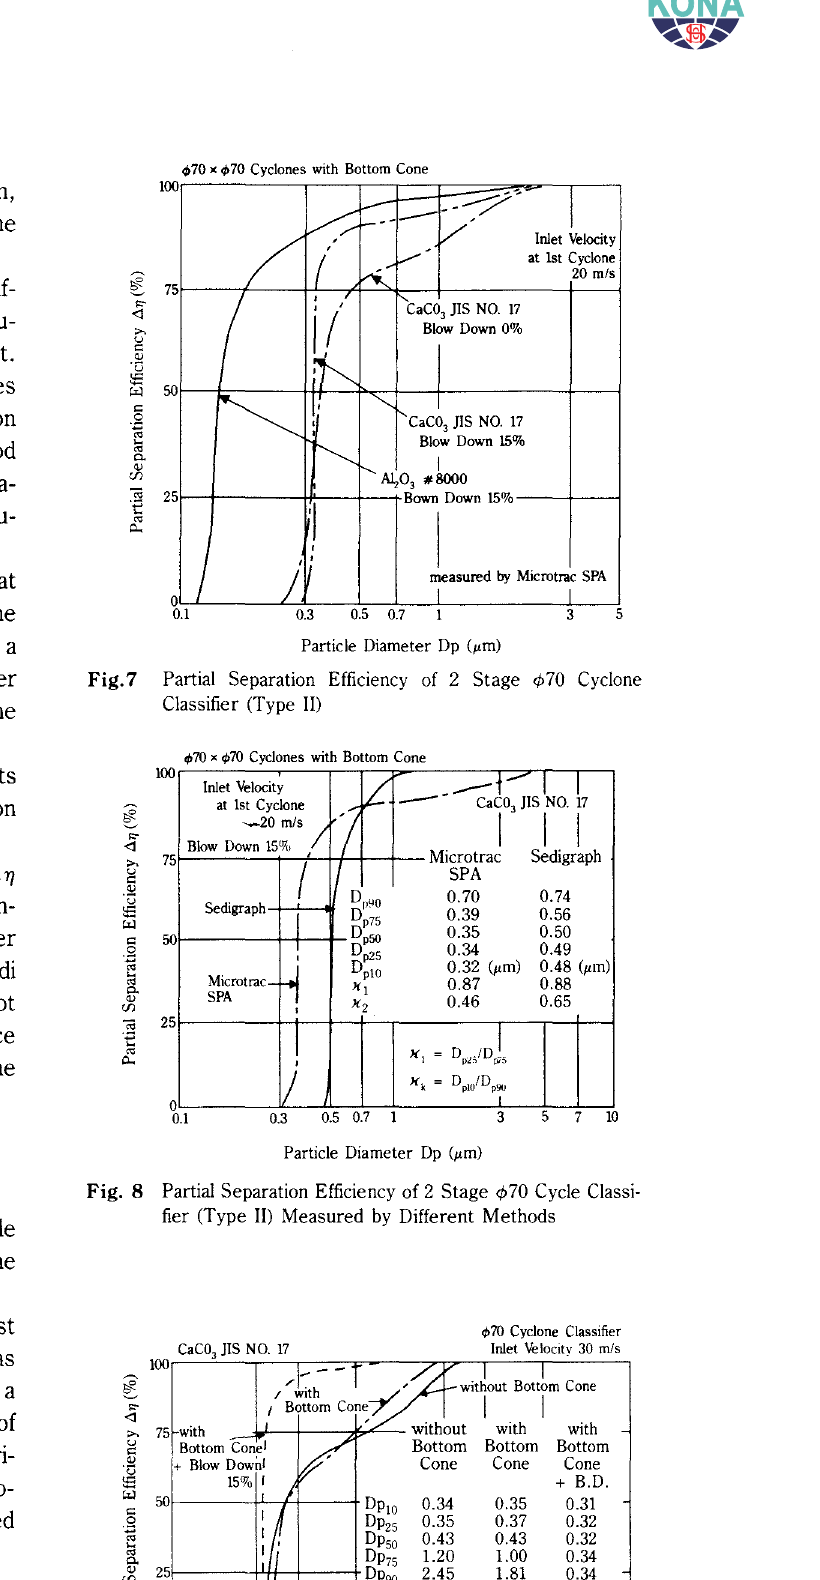
Fig. 9 Partial Separation Efficiency of ¢70 Cyclone Classifier with and without Bottom Cone and Blow Down Rate 15o/o (CaC03 JIS No. 17) (Type I)